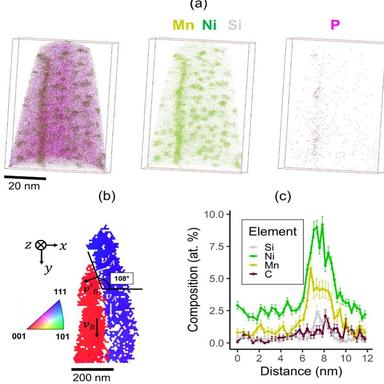
(a) Atom maps showing the segregation of Mn, Ni, Si, and P to a planar feature, likely a grain boundary identified in (b) TKD orientation map of neutronirradiated steel specimen that contains a grain boundary. (c) One-dimensional compositional profile of Mn, Ni, Si, and C through a region of the grain boudary in (a).